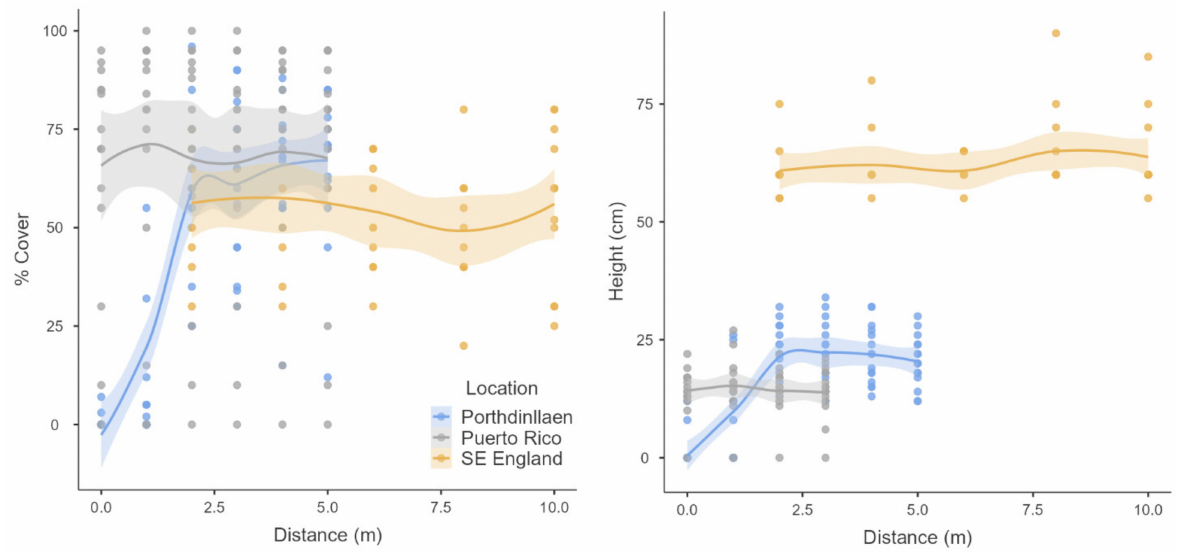
Figure 1. Seagrass % cover (left) and canopy height (right) with increasing distance from the base point of established boat moorings made from synthetic fibre rope in three locations (Porthdinllaen, north Wales, Puerto Rico, south England coast). A quadratic smoothed regression line is shown ± its standard error. Data were collected at the four cardinal points of the compass around the